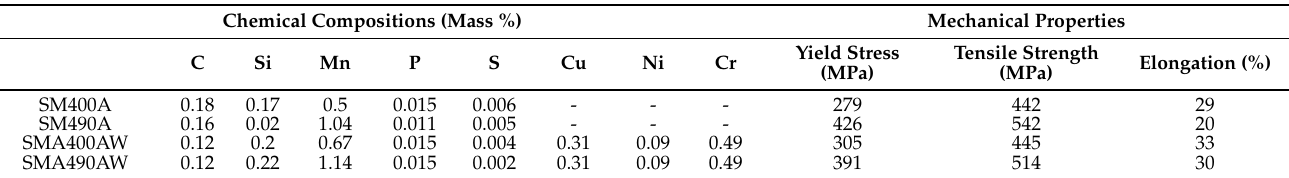
Table 2. Chemical compositions and mechanical